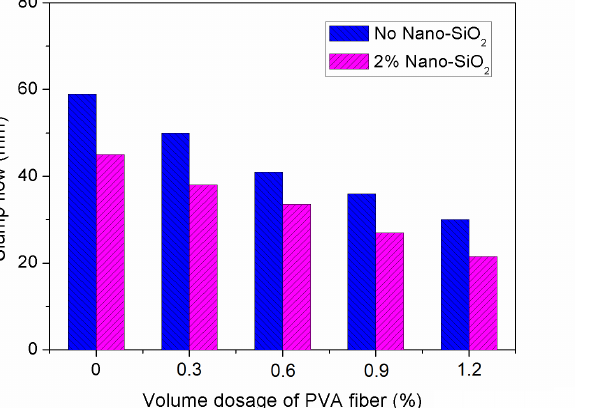
Figure 1: Effect of PVA fiber on slump flow